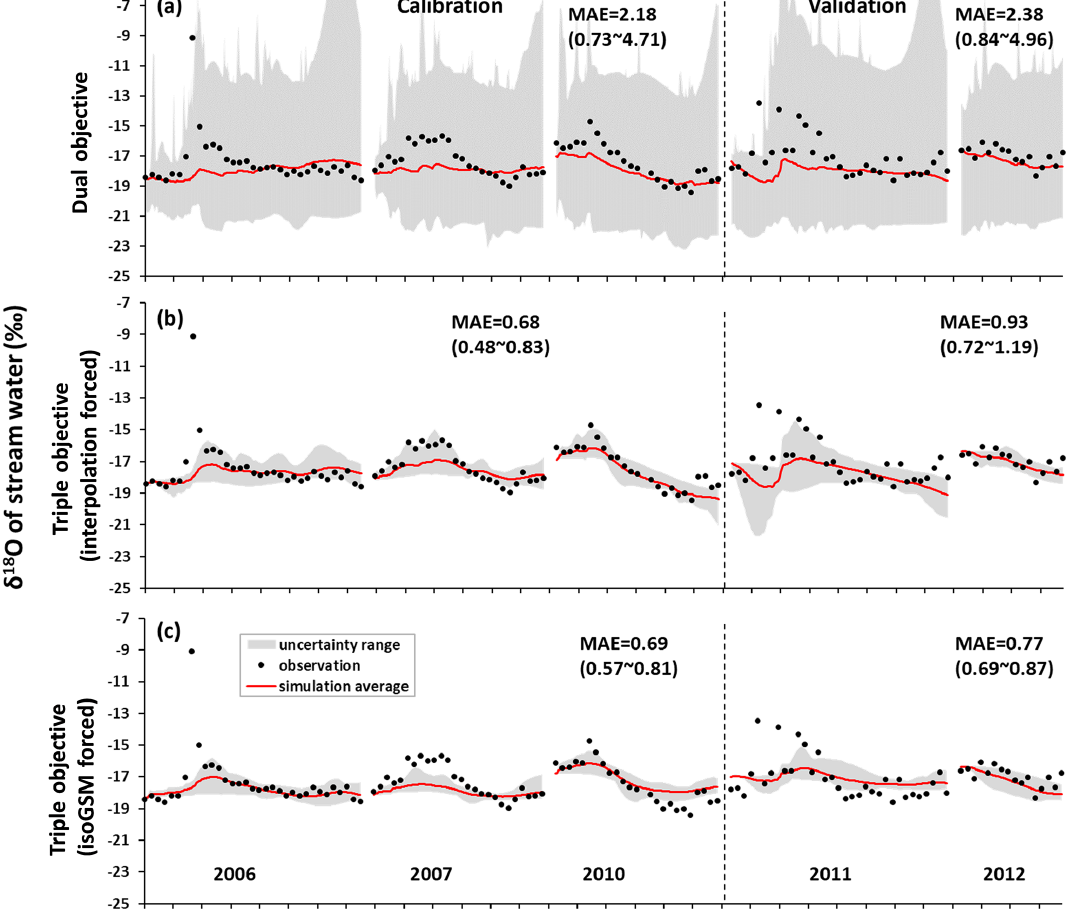
Figure 10. Uncertainty ranges of stream water δ 18 O simulations in the KR catchment during the calibration and validation periods produced by the behavioral parameter sets of the dual-objective (a) , interpolation-forced triple-objective (b) and isoGSM-forced triple-objective (c) calibration variants.